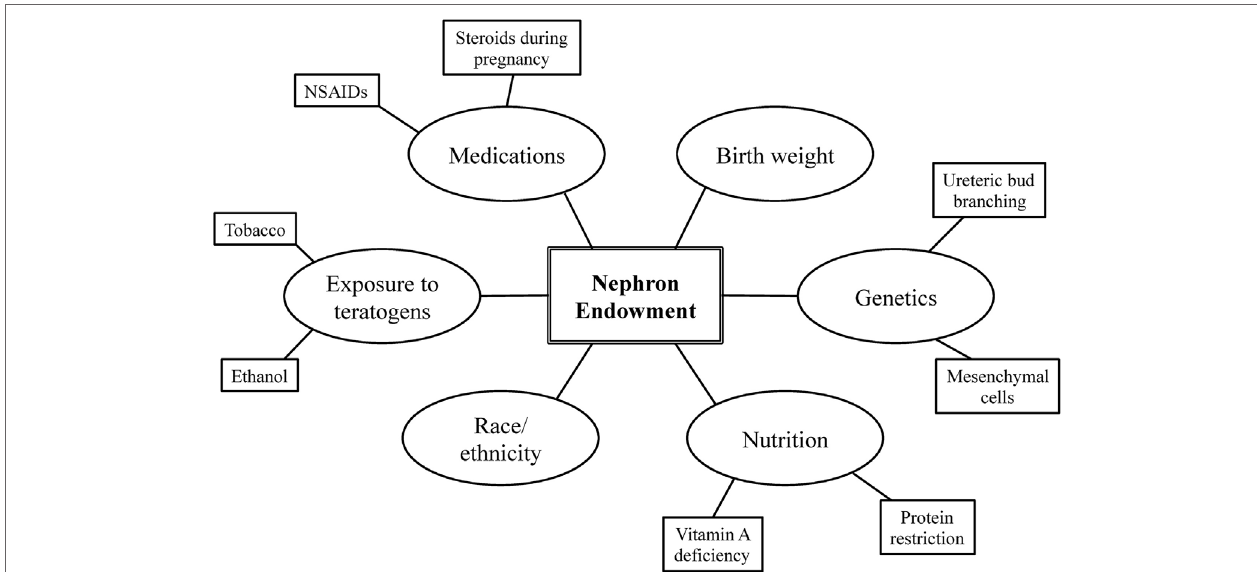
FigURe 1 | Factors influencing nephron